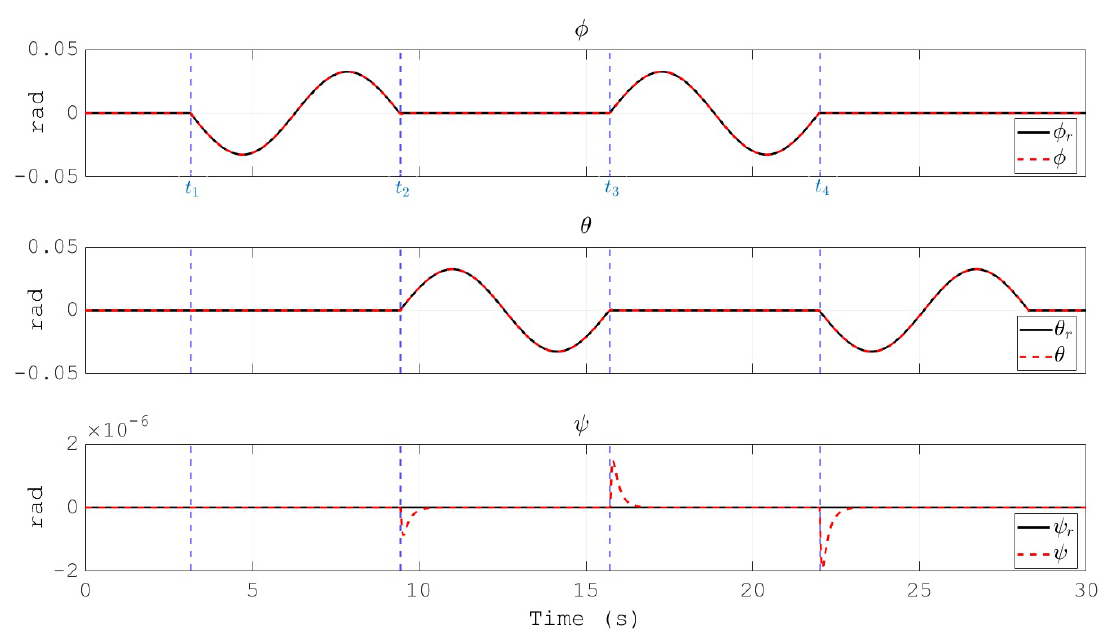
Figure 11. Euler angles of the multirotor and their